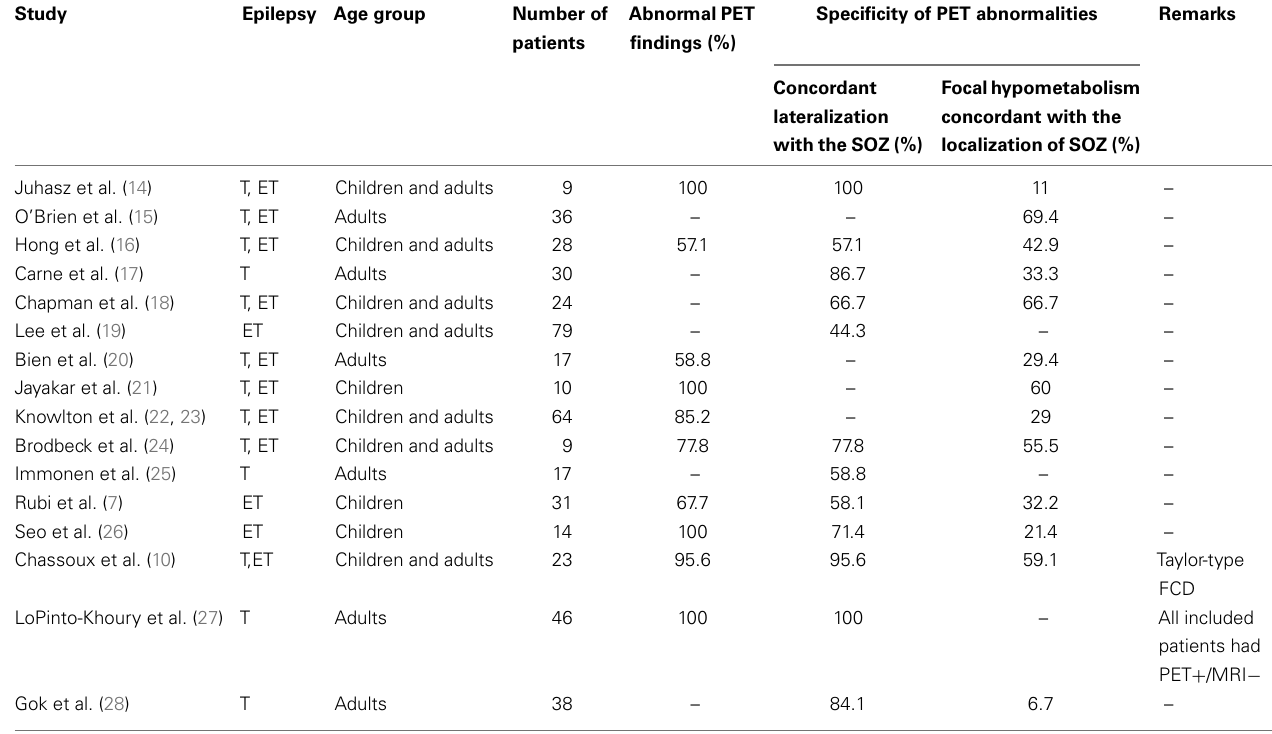
Table 1 | Diagnostic accuracy of [ 18 F]-FDG-PET in MRI-negative focal